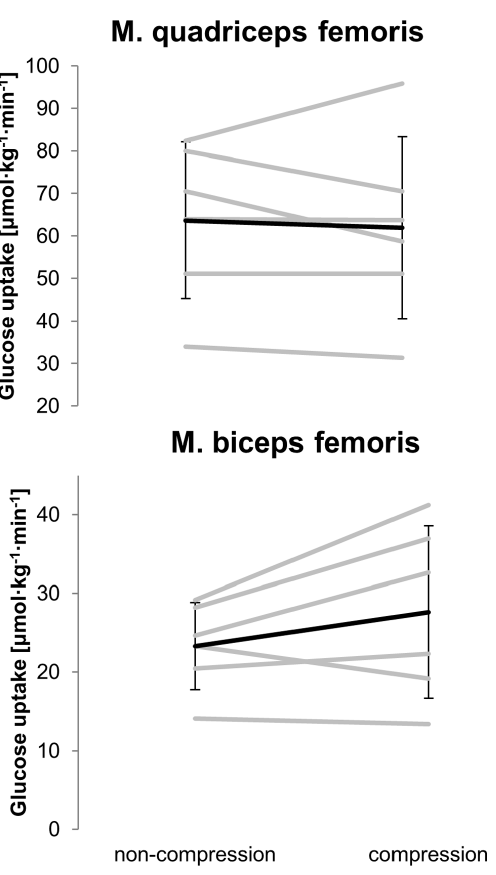
Figure 4. Glucose uptake. M. quadriceps femoris (above) and m. biceps femoris (below) without and with compression during recovery from high intensity exercise.